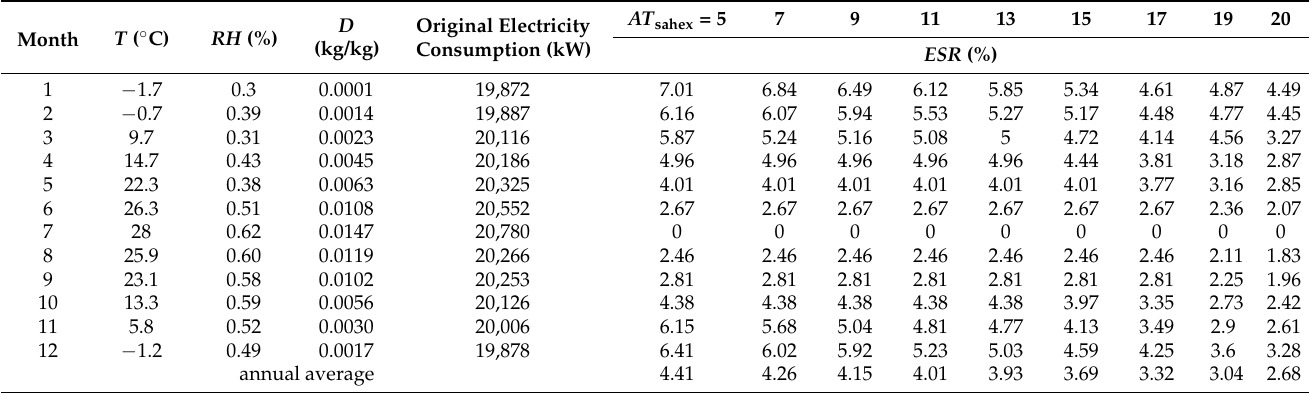
Table 6. Monthly energy saving ratio in